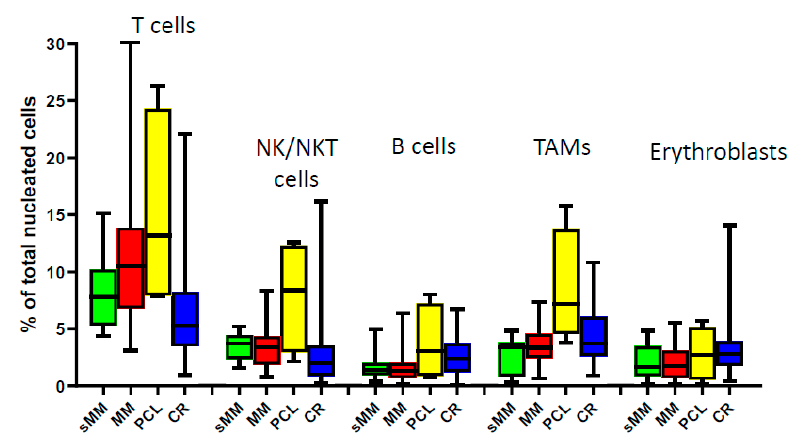
Figure 1. Bone marrow composition of major immune subsets at different stages during MM progression. sMM: smoldering myeloma; MM: multiple myeloma; PCL: plasma cell leukemia; CR: complete remission; NK/NKT: natural killer cells/natural killer T cells; TAMs: tumor-associated